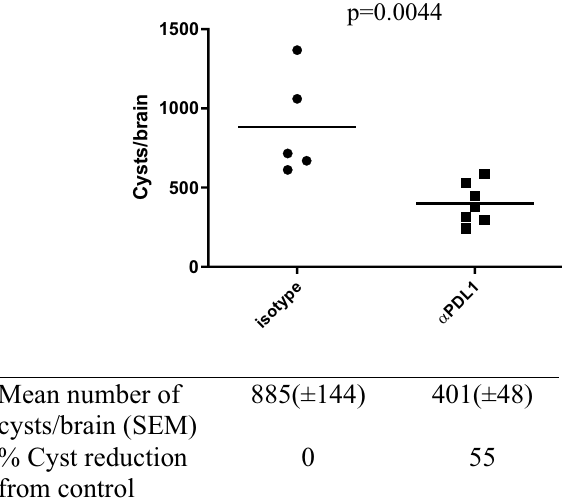
Figure 1. The efficacy of αPD-L1 monoclonal antibodies against latent Toxoplasma infection. Nine-week-old BALB/c mice were infected i.p. with 400 tachyzoites of Pru strain. At 6 wpi, anti-PD-L1 antibodies or isotype controls were administrated to infected mice every 3 days for 2 weeks. Six weeks after the final injection, mice were sacrificed to count the number of tissue cysts in the brain. Compared to isotype control, the number of tissue cysts was reduced by 55% in mice treated with αPD-L1. P value is calculated by Student’s t-test. Shown are the individual data points with a mean